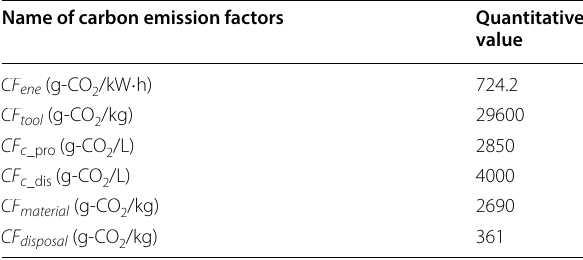
Table 3 Equivalent carbon emission